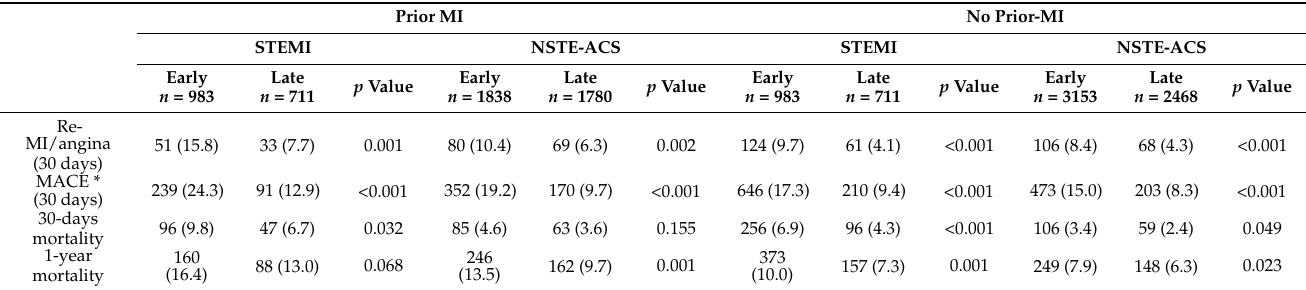
Table 5. Clinical outcome of patients with and without prior MI admitted with STEMI vs. NSTE-ACS compared between time periods (early 2000–2008 vs. late